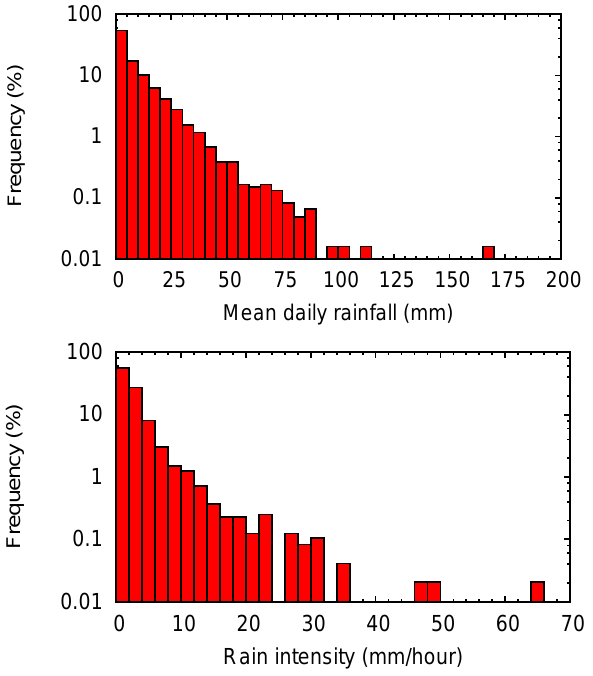
Fig. 2. Top: Maximum loading of a wet vs. dry tephra deposit for rainfall of 100mm and 200mm, assuming a deposit porosity φ tot = 0 . 68. The inflection points in the curves occur for φ tot h dep = h max . Bottom: Effect of porosity on the load of wet deposits, for a rainfall of 200mm: a change in the deposit porosity produces in a shift of the inflection